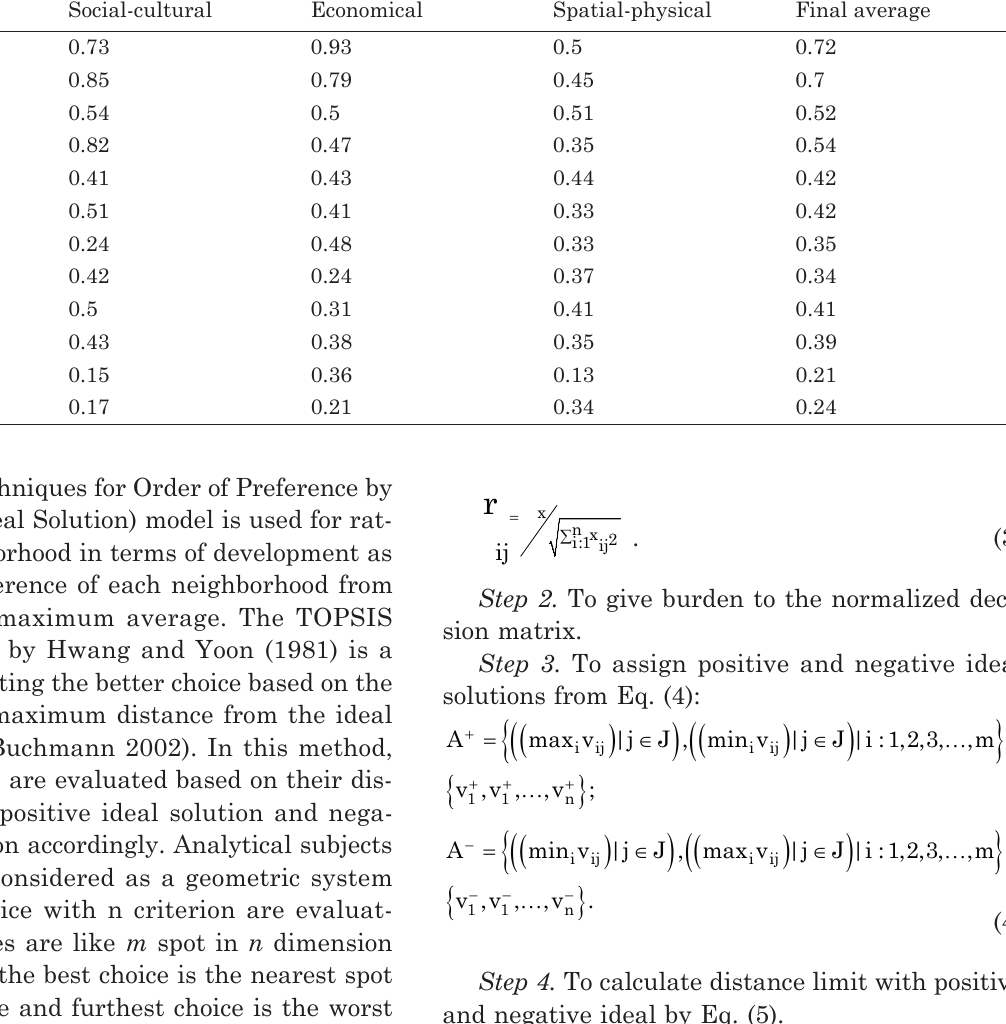
Final averageSpatial-physicalEconomicalSocial-culturalNeighborhoods